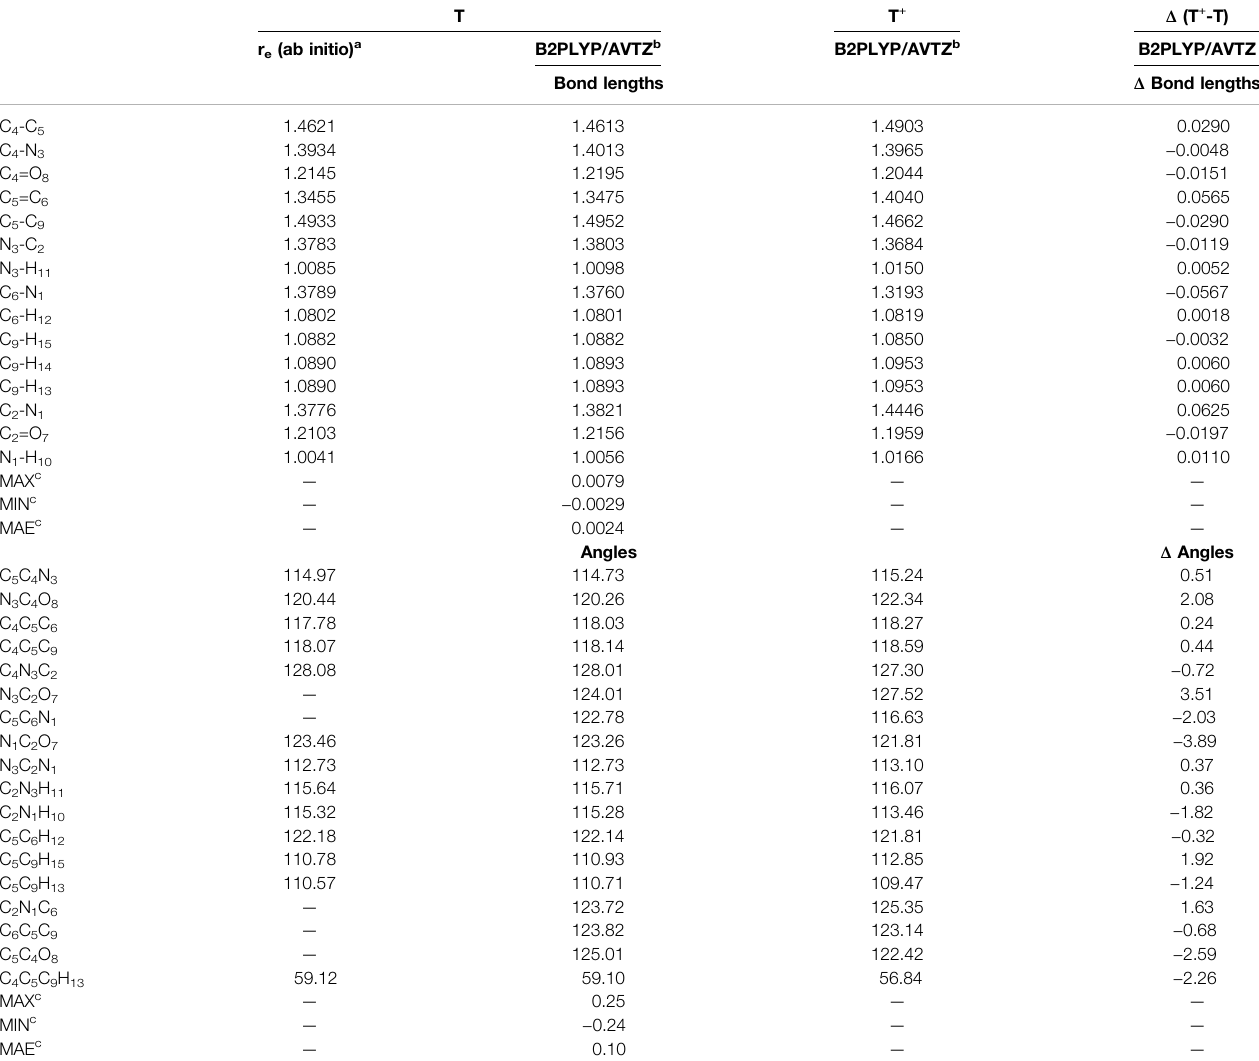
TABLE 1 | Structural parameters of neutral Thymine and its cation (bond lengths in Å, angles in